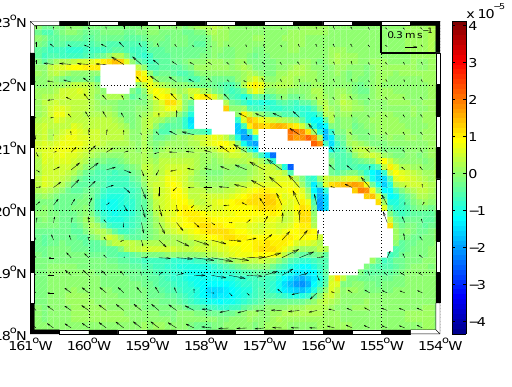
Fig. 8. Relative vorticity field with velocity vectors at 10-m depth on August 25 for Run-E (left) and Run-F (right).